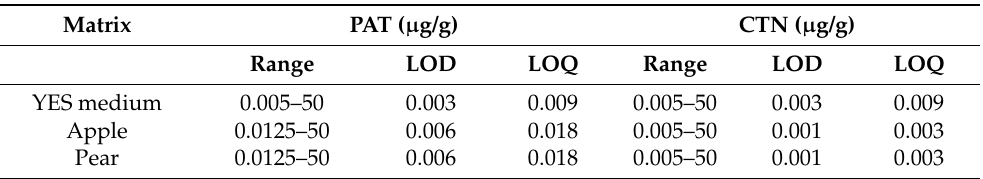
Table 1. Concentration range ( µ g/g) of calibration curves for analysis of PAT and CTN in YES medium and fruits with corresponding LOD and LOQ ( µ g/g). Matrix PAT ( µ g/g) CTN ( µ g/g) Range LOD LOQ Range LOD LOQ YES medium 0.005–50 0.003 0.009 0.005–50 0.003 0.009 Apple 0.0125–50 0.006 0.018 0.005–50 0.001 0.003 Pear 0.0125–50 0.006 0.018 0.005–50 0.001 0.003